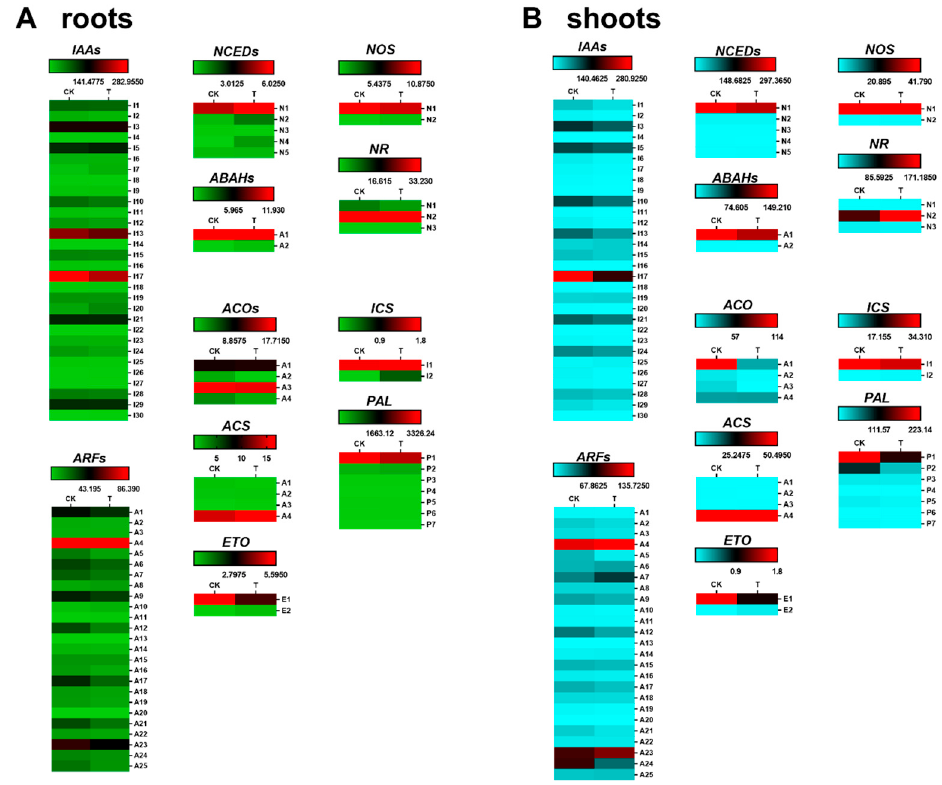
Figure 3. Different expression genes of signal factors (IAA, ABA, ethylene, nitric oxide, and melatonin) in root ( A ) and shoot ( B ). (CK is the control group with 1 mM phosphate and 8.896 µ M cadmium, T is treatment group with 3 mM phosphate and 8.896 µ M cadmium; n = 3).